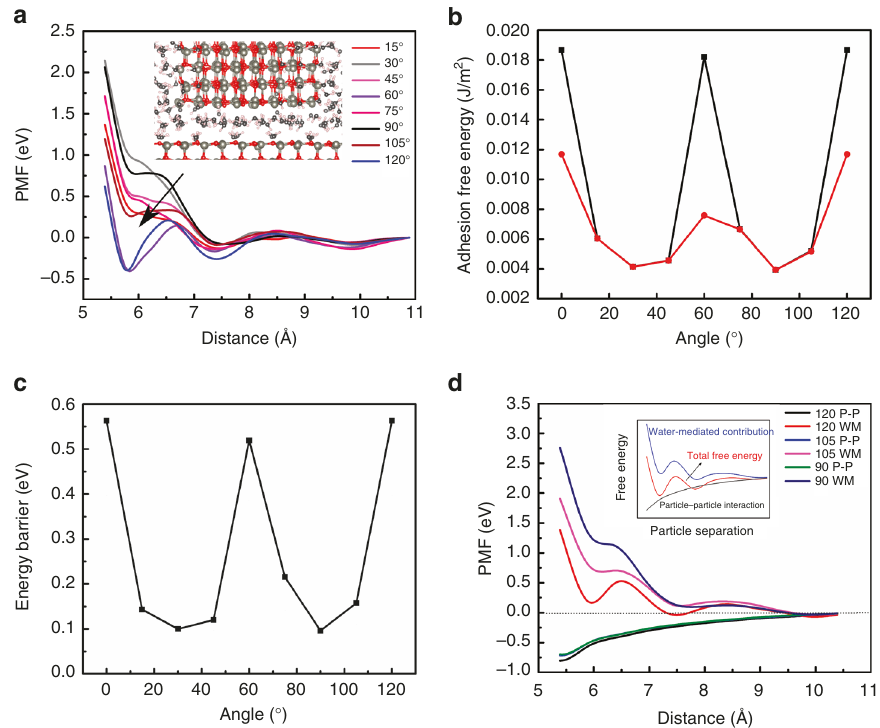
Fig. 4 Calculated PMF curves and energy barriers for ZnO(0001) – ZnO(0001) interactions at different azimuthal angles. a PMF curves at different azimuthal angles. An exemplary con fi guration at the fi rst energy well is also shown. b Adhesion-free energies between ZnO particle and the substrate by using global minima ( black fi lled circles ) and second minima ( red fi lled circles ), at different angles. For better comparison with the adhesion-free energies estimated from experiments as shown in Fig. 3d, the free energies obtained from a are normalized to the surface area and the unit of J m − 2 is used. c Energy barriers for moving the particle out of the lowest energy minima at different angles. d Comparison of contributions to the total PMF from particle – particle (P – P) interactions and from the water-mediated forces at 90°, 105°, and 120°. The total PMF and the P – P interaction contribution are calculated from MD simulations, and the water contribution is obtained as a difference between the previous two terms as shown in the